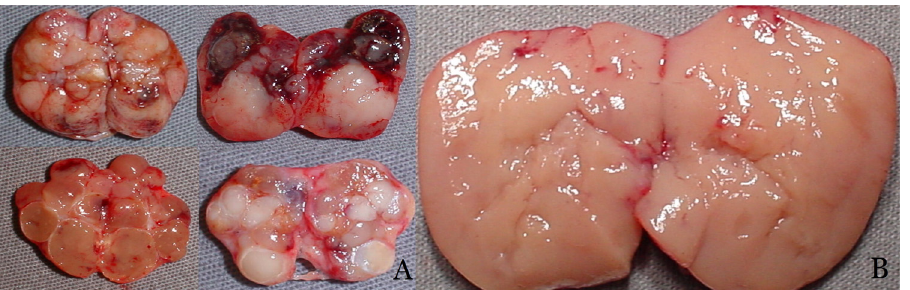
Figure 1 Macroscopic parathyroid tissue observation: A, nodular parathyroid regions not eligible for autotransplantation; B, hyperplasic non-nodular parathyroid area eligible for autotransplantation.